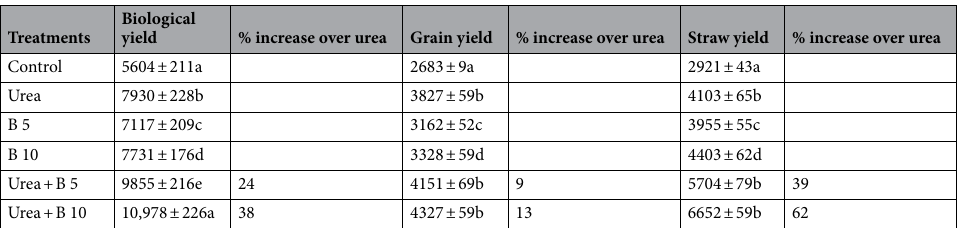
Table 2. Total aboveground biomass, and grain and straw yield (kg ha −1 ) in soils amended with sole urea or urea + biochar treatments. Values within a column followed by the same letter are not-significantly different at P < 0.05.